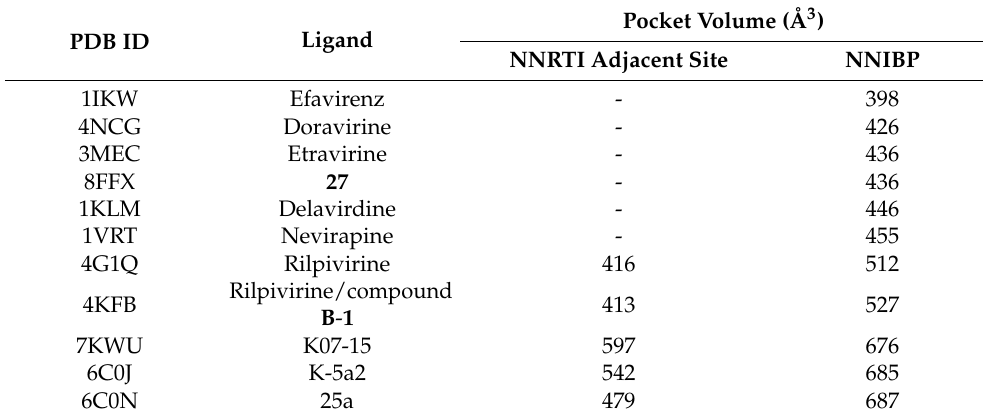
Table 4. PyVOL pocket volume analysis of the NNIBP and NNRTI Adjacent site in NNRTI-bound RT structures. A minimum and maximum probe radius of 1.8 and 3.4 Å was used. Dashes indicate a closed pocket with no measurable volume.